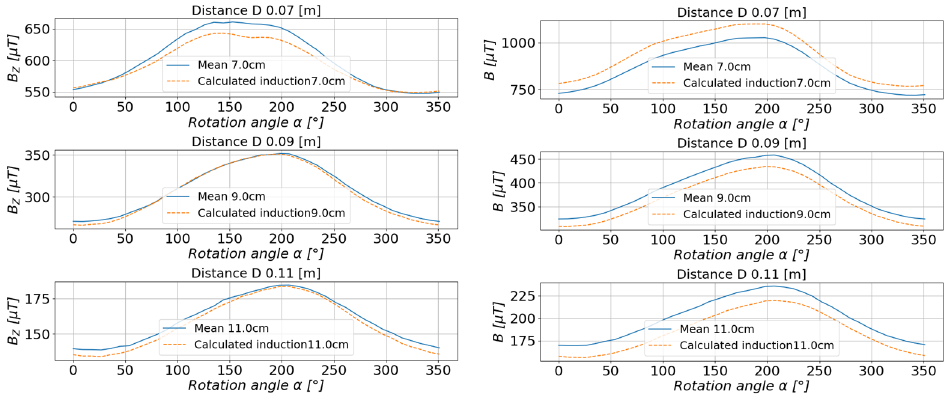
Figure 17. Comparison of the estimated values with the measured values of the magnetic induction in the measurement axis Z ( left ) and the resultant value of the scalar magnetic induction B ( right ).